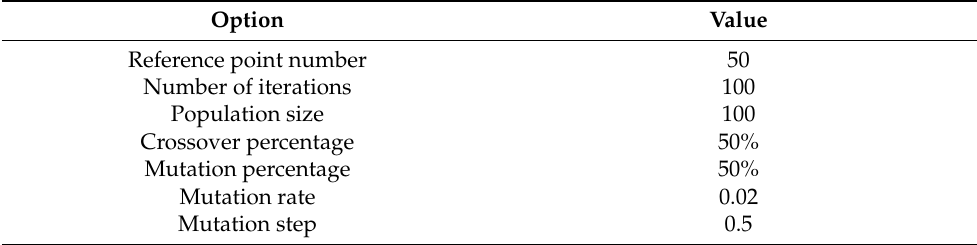
Table 4. Settings of NSGA-III.